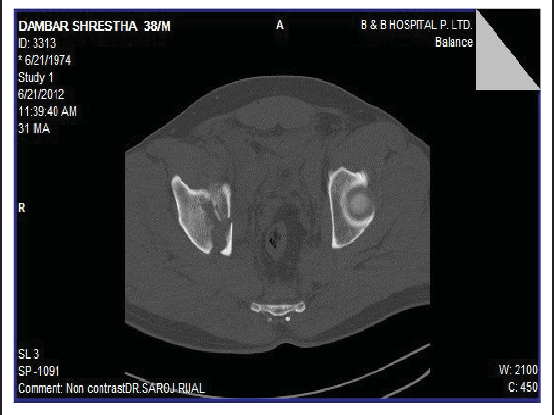
Figure 2. 38 Y/ M . Axial CT image shows T-shaped fracture of right